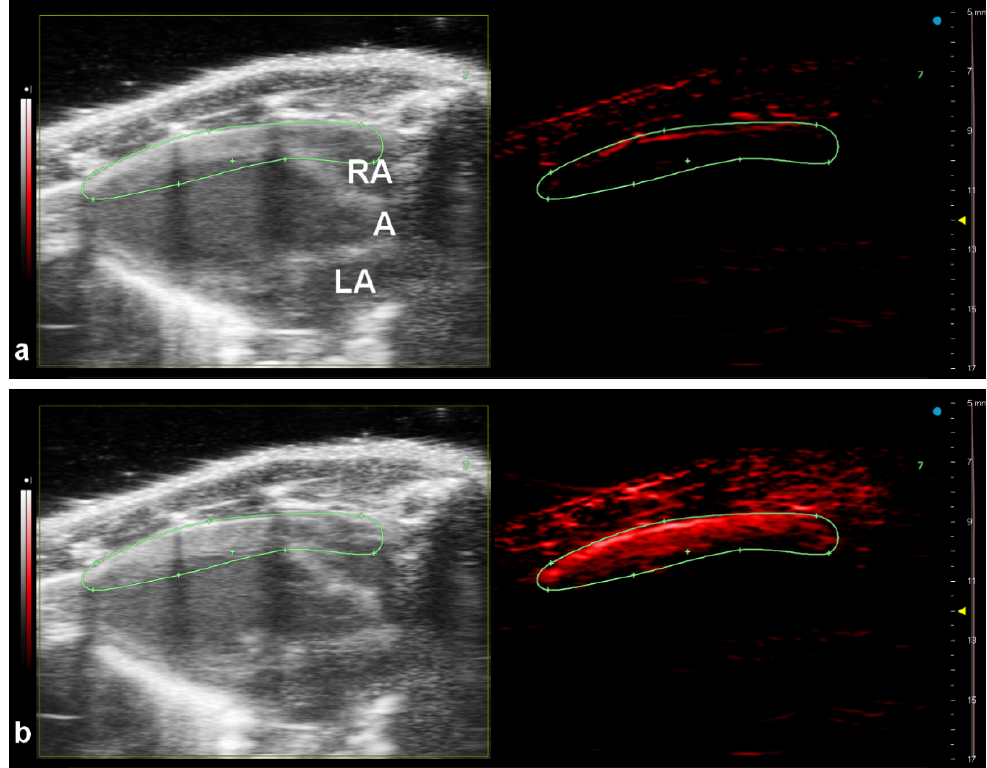
Figure 6. Multimodal US ‐ PA imaging of the mouse heart in its long axis in B ‐ Mode (left panels) and PA ‐ Mode (right panels) before intravenous PPyF4 nanoparticle administration ( a ) and 5 s after bolus injection (180 μ L) ( b ). The PA detection was at single wavelength mode obtained at 800 nm. RA—right atrium, A—aorta, LA—left atrium.